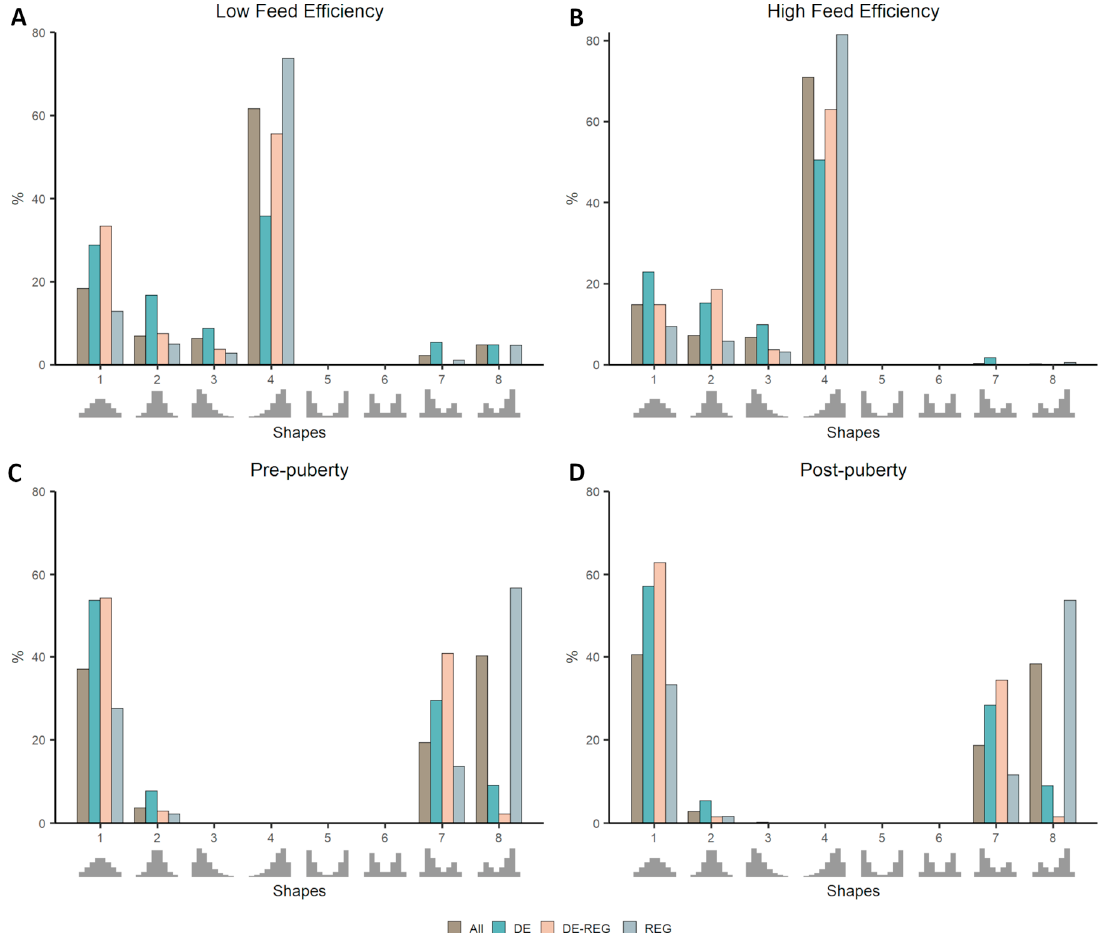
Figure 3. Proportion of genes falling in each template shape in contrasting phenotypic conditions within cattle datasets: low feed e ffi ciency ( A ), high feed e ffi ciency ( B ), pre-puberty ( C ), and post-puberty ( D ). The proportion of genes classified as DE, REG, or DE-REG are compared to the overall (All) proportion of genes within each shape.